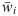
Possible hard palate shapes generated from the first three Principal Components derived from our sample of MRI scans using various weights.The first panel (top left, “average palate”) shows the curve generated using the average loadings across the sample on the first three PCs (w¯i, i ∈ {1, 2, 3}), while the following three top and three mid panels show the curves generated going the same number of standard deviations away (positive or negative) from the sample averages (i.e., the panel “+1sd” was constructed with weights w¯i+1.0sd(wi)). The bottom four panels show various combinations (in no particular order) of deviations (in terms of standard deviations) from the sample average. It can be seen that while the curves generated in the neighborhood of the sample average seem plausible human HPPs, the farther away one deviates from this average, the less plausible these shapes become.